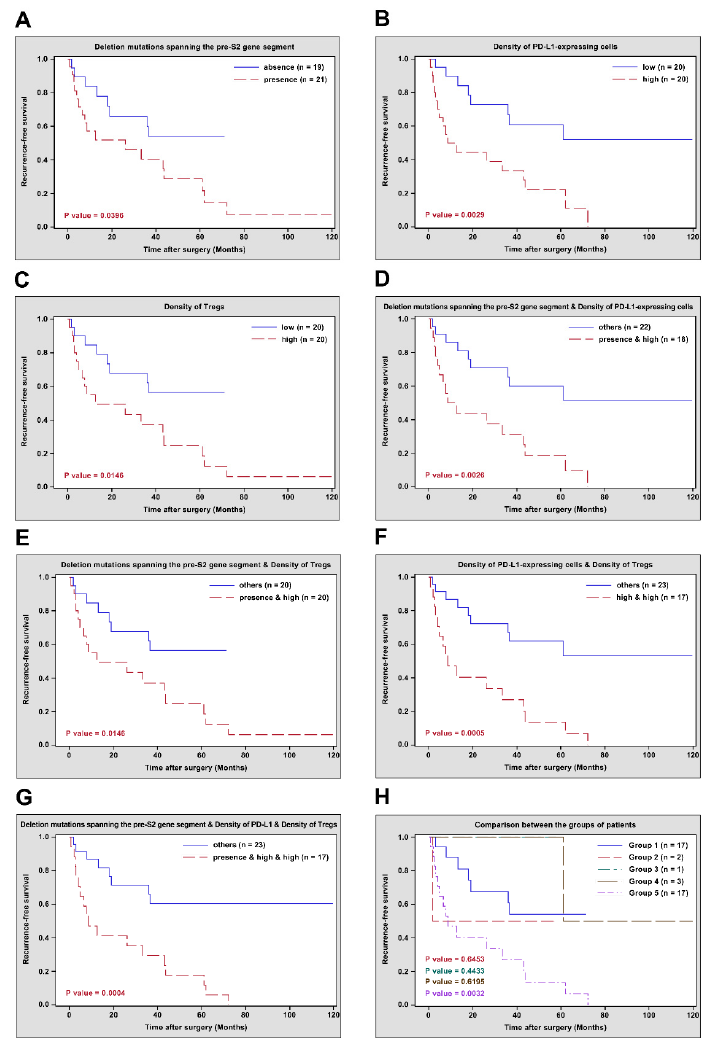
Figure 1. RFS curves in different groups of HBV-related HCC patients after curative surgical resection. ( A ) RFS curves in patients with presence versus absence of deletion mutations spanning the